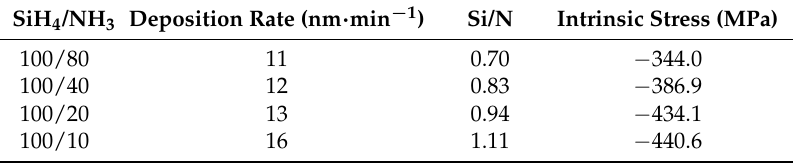
Table 3. Influence of SiH 4 /NH 3 with the intrinsic stress level and deposition